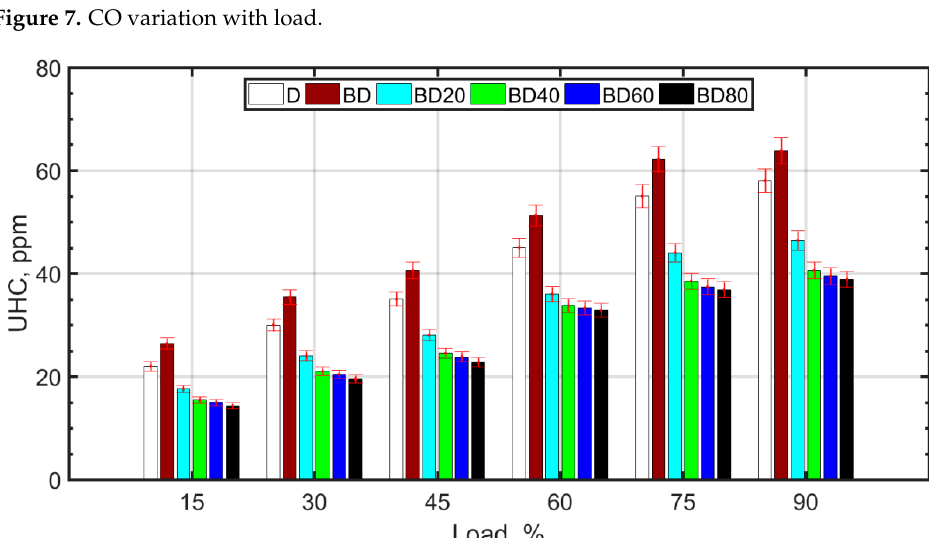
Figure 8. UHC variation with load.